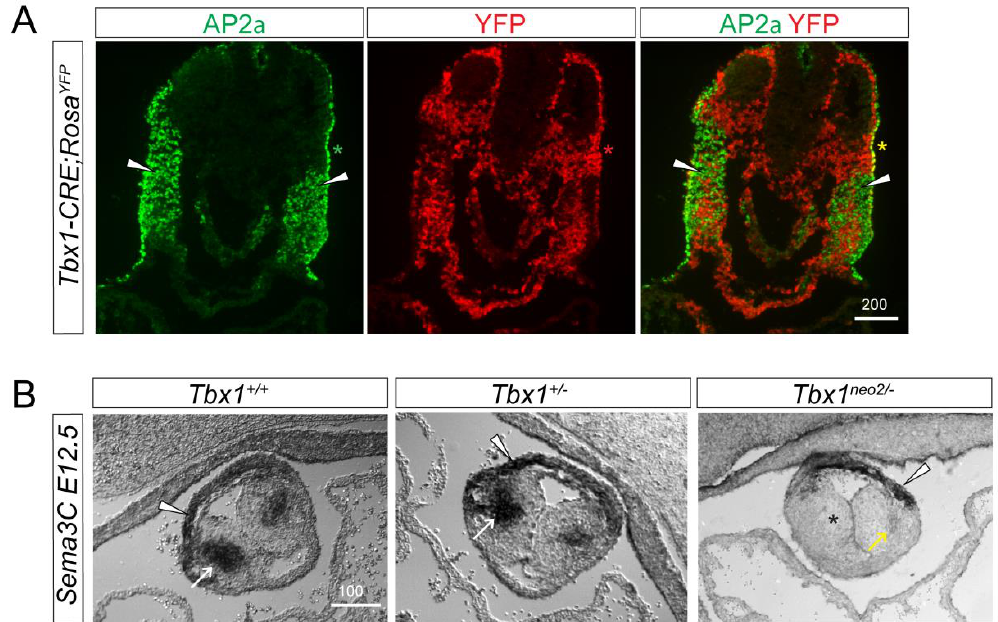
Figure 2. Cardiac neural crest cell defects in Tbx1 mutant embryos. ( A ) E9.5 Tbx1CRE-Rosa YFP embryos were stained for the cNCC marker AP2 α together with YFP as a marker for the Tbx1 -lineage. cNCCs and Tbx1 do not colocalise (arrowheads). ( B ) E12.5 Tbx1 +/+ , Tbx1 +/ − and Tbx1 neo2/ − outflow tracts were stained for the cNCC marker Sema3C . cNCCs have migrated into the outflow tract cushions in Tbx1 +/+ and Tbx1 +/ − but not in Tbx1 neo2/ − embryos. White arrowheads and arrows indicate Sema3C expression in myocardial cuff cells and the septal bridge area, respectively. Asterisk indicates absent Sema3C in the outflow tract right cushion. Yellow arrow marks residual Sema3C -positive cNCCs in the outflow tract left cushion. Scale Bars are in µ